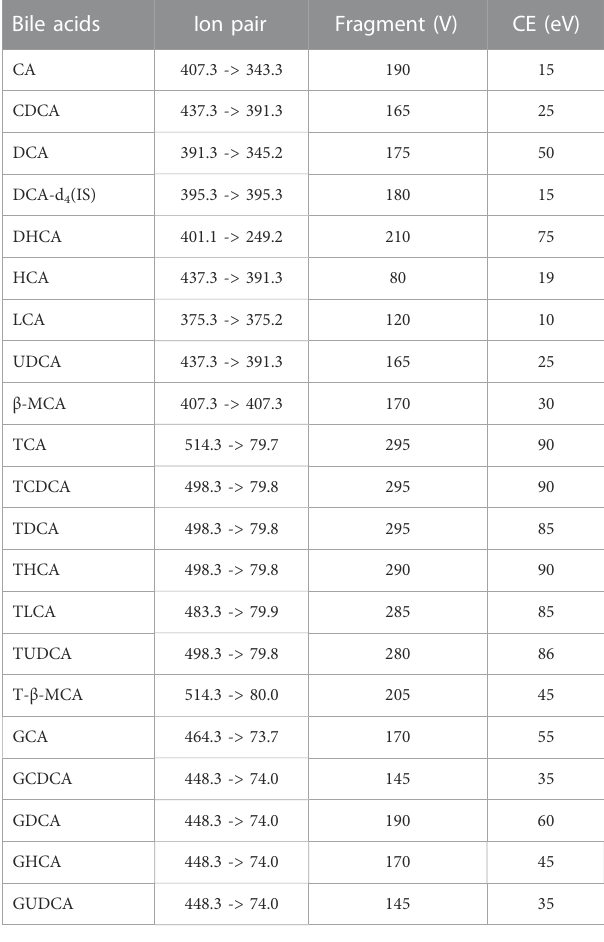
TABLE 2 MRM transitions and MS parameters in negative ion mode for all bile acids. Bile